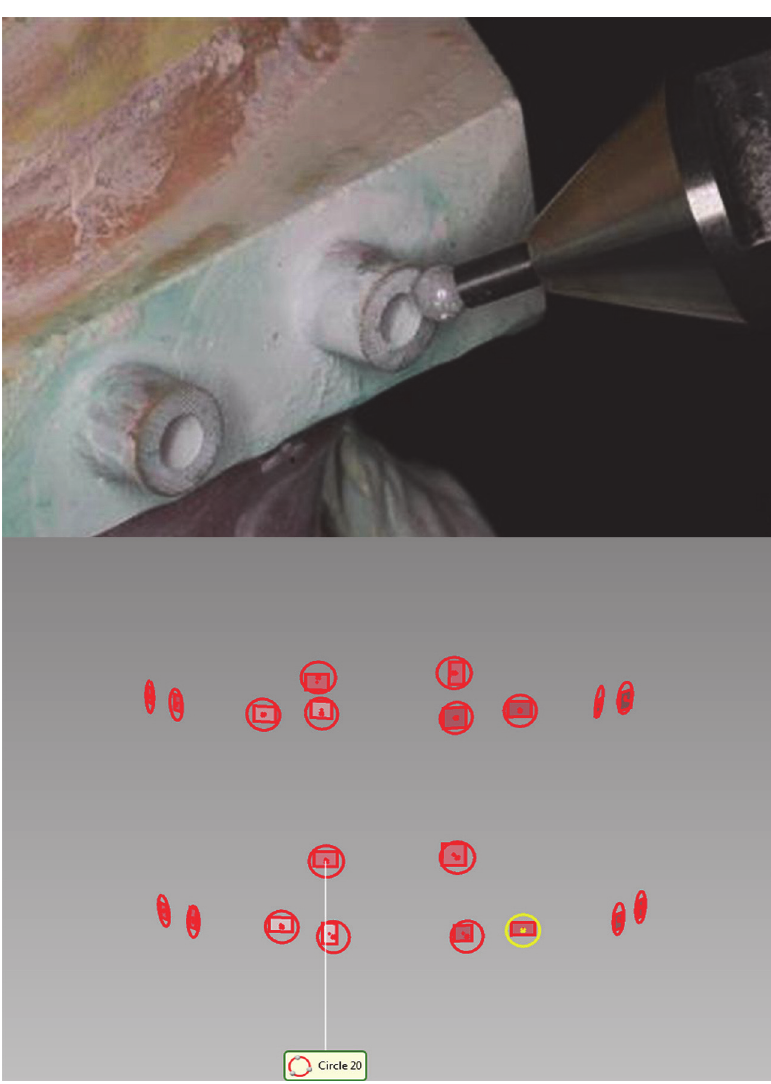
Fig 1. Determination of contact method center